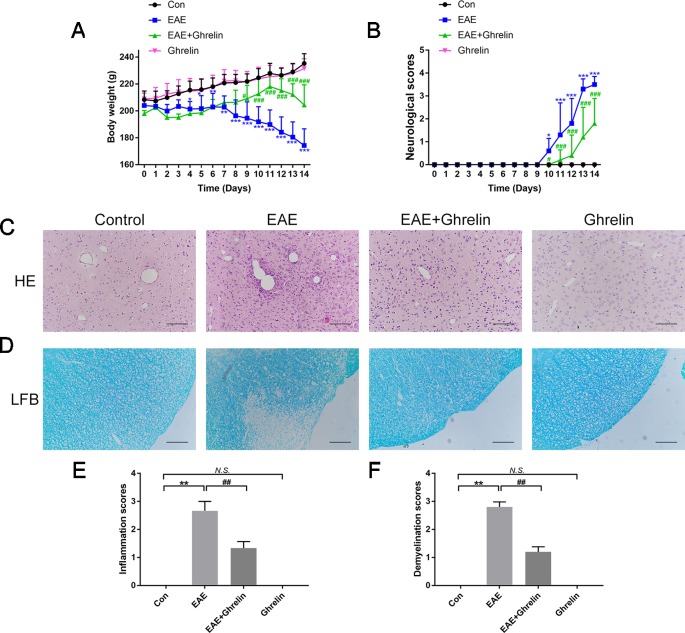
Treatment of ghrelin ameliorated symptoms and suppressed inflammatory infiltration and demyelination in CNS tissues of EAE rats. (A) Body weight changes of rats during the experimental period (n = 10). (B) Variations of neurological scores during the experimental period (n = 10). Statistical analysis of different groups was performed with two-way ANOVA followed by Bonferroni’s multiple group comparison. (C) H&E staining showed that ghrelin attenuated inflammatory infiltration in brain tissues of EAE rats. (D) LFB staining showed that ghrelin attenuated demyelination in spinal cord tissues of EAE rats. Inflammation scores (n = 5) (E) and demyelination scores (n = 5) (F) were markedly decreased in the ghrelin-treated group. Scale bars: 50 µm. Data were shown as mean ± SD. *P 0.05, **P 0.01,***P 0.001 versus the control group, #
P 0.05, ##
P 0.01, ###
P 0.001 versus the EAE group. NS, not significant. Con, control.